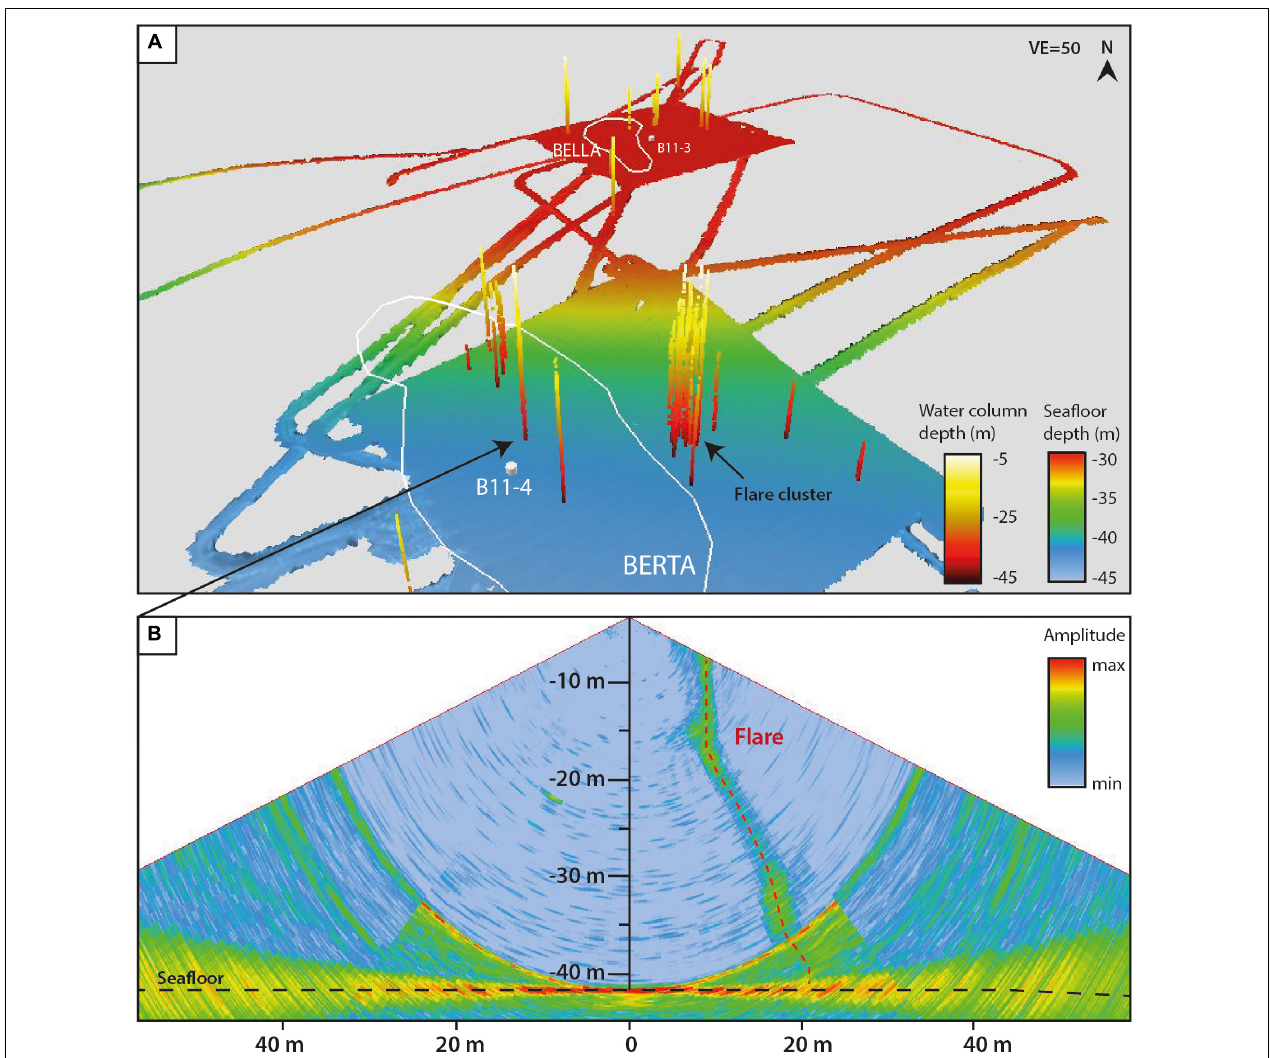
FIGURE 2 | (A) Flares extracted from the water column data imaged with the bathymetric data, recorded by ship-based multibeam echosounder Kongsberg EM710 during R/V Heincke cruise HE537. White outline: subsurface salt diapirs (Arfai et al. (2014), white dots: abandoned well sites (from Lower Saxony’s borehole database: www.lbeg.niedersachsen.de). (B) Swath image of the water column data illustrating a flare detected above salt diapir Berta. The flare represents the pathway of gas bubbles released in 42 m water depth through almost the entire water column.